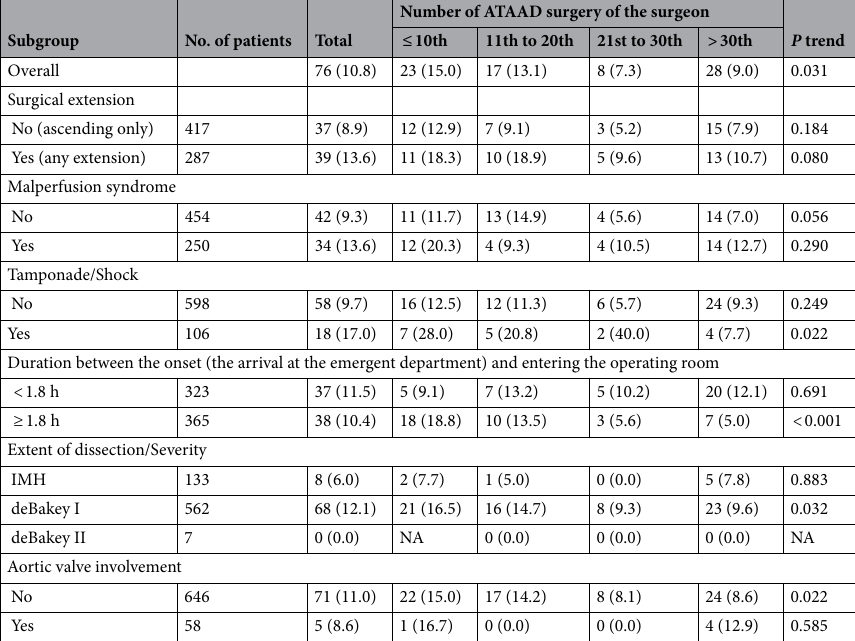
Table 2. In-hospital mortality of the patients according to the cumulative operation volume of the surgeon by different subgroups. ATAAD acute type A aortic dissection, ICU intensive care unit, NA not